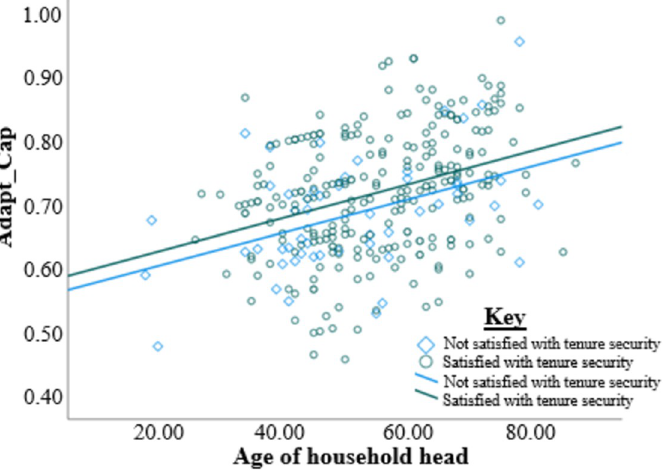
Fig 2. The interaction between the age of the household head and land tenure security (all other factors controlled).